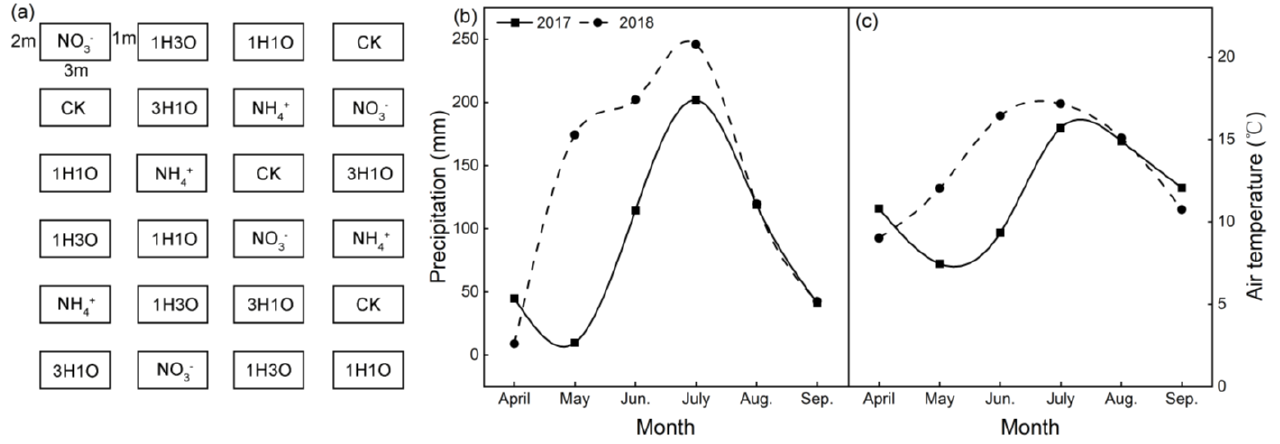
Figure 1. Experimental design ( a ), precipitation ( b ) and air temperature ( c ) in experimental duration between 2017 and 2018. CK, the control; NH 4 + , the total NH 4 + ; 3H1O, tripled NH 4 + :NO 3 − ; 1H1O, NH 4+ equal to NO 3 − ; 1H3O, NH 4+ :tripled NO 3 − ; NO 3 − , total NO 3 − . In 2017 to 2018, five different ratios of NO 3 − and NH 4+ N addition experiments (N fertilization 16 g N m − 2 yr − 1 ) were simulated in 2 × 3 m plots with six treatments and four replicates of each treatment. All plots were separated by at least 1 m, and each plot was randomly arranged (Figure 1). In late April, all of N (analytically pure) was fertilized and N was mixed with soil from the test plot and spread on the surface of the soil evenly. The nitrogen addition treatment is as follows: (1) the control (no fertilization, defined as CK), (2) the total NH 4+ (defined as NH 4+ ), (3) tripled NH 4+ :NO 3 − (defined as 3H1O), (4) NH